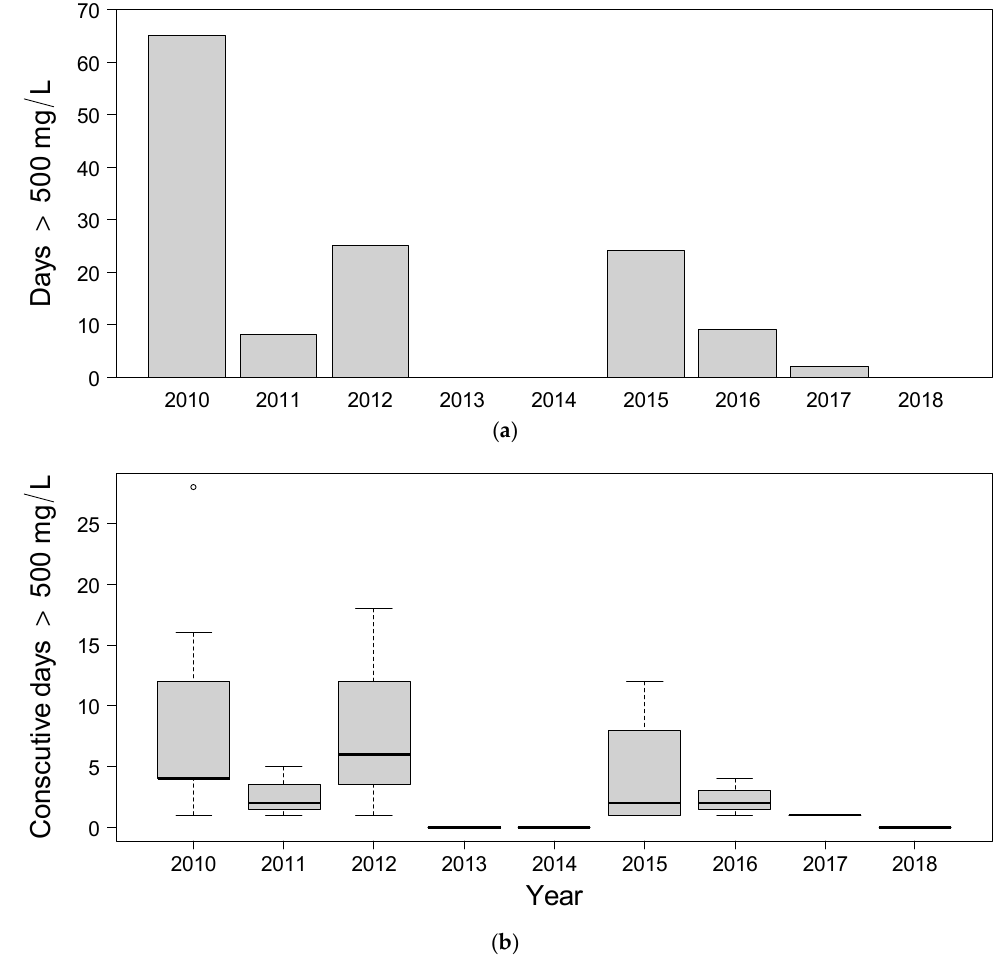
Figure 3. ( a ) Histogram showing number of days each year with total dissolved solids (TDS) exceeding 500 mg/L within the West Fork (WF) River; ( b ) Box plots showing the number of consecutive days TDS exceeded 500 mg/L during exceedance events occurring each year.